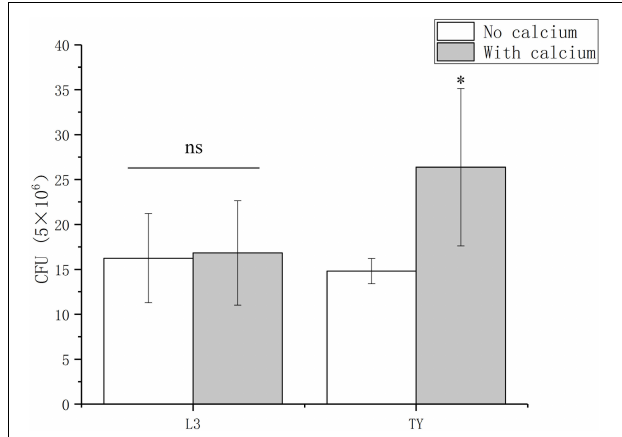
FIGURE 6 | Colonization of wild type on S. rostrata roots with L3 or TY medium including calcium or not. The concentration of calcium in L3 and TY mediums is 0.36 and 6 mM, respectively. Values are shown as the means and standard deviations from at least three independent experiments. Asterisks ( ∗ ) means p < 0.05 vs. each medium without calcium by a Student’s t